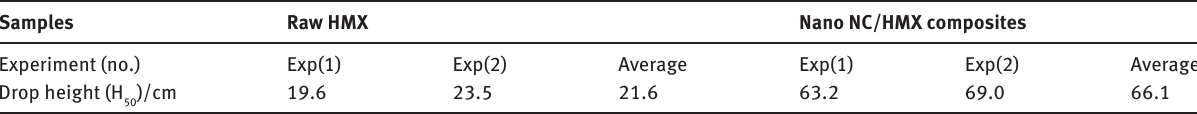
Table 1: Drop height of raw HMX and nano NC/HMX composites. Samples Raw HMX Nano NC/HMX composites Experiment